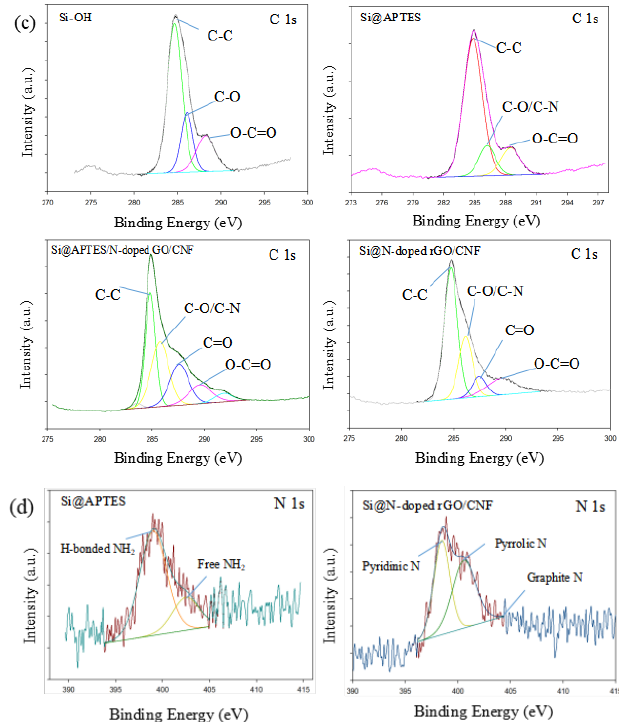
Figure 5. ( a ) Survey XPS spectra of Si@APTES, Si@APTES/N-doped GO, Si@APTES/N-doped GO/CNF, Si@N-doped rGO, and Si@N-doped rGO/CNF, ( b ) Si 2p XPS spectra of Si, Si-OH, Si@APTES, Si@APTES/N-doped GO, Si@APTES/N-doped GO/CNF, Si@N-doped rGO and Si@N-doped rGO/CNF, ( c ) C 1s XPS spectra of Si-OH, Si@APTES, Si@APTES/N-doped GO/CNF and Si@N-doped rGO/CNF, ( d ) N 1s XPS spectra of Si@APTES and Si@N-doped rGO/CNF.